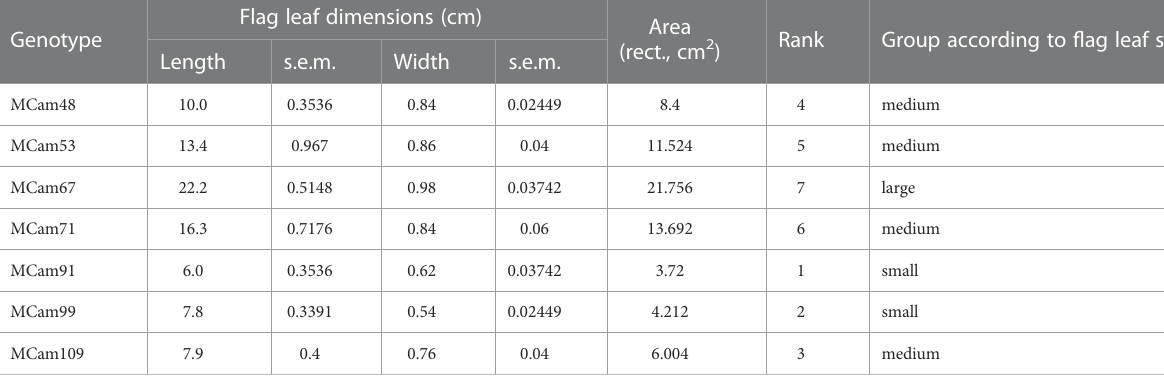
TABLE 1 Grouping of barley genotypes with respect to the fl ag leaf size.